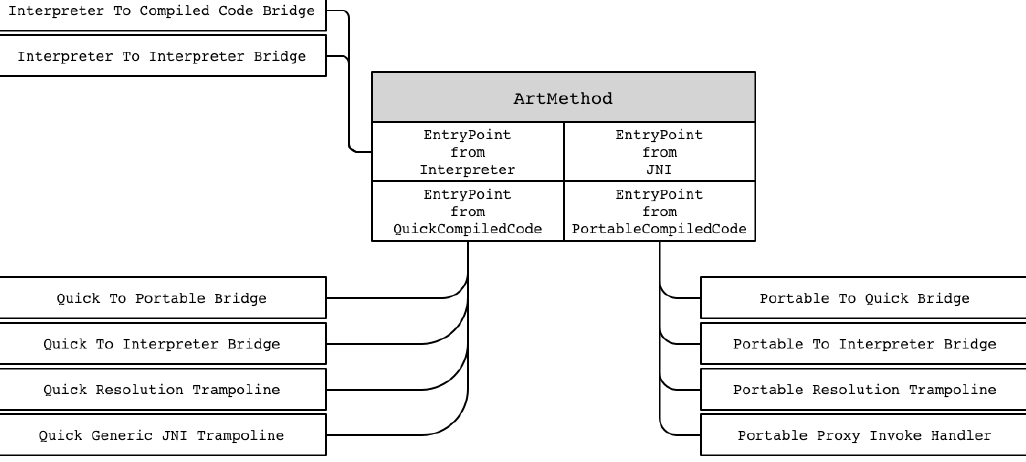
Figure 2. List of ArtMethod class entry